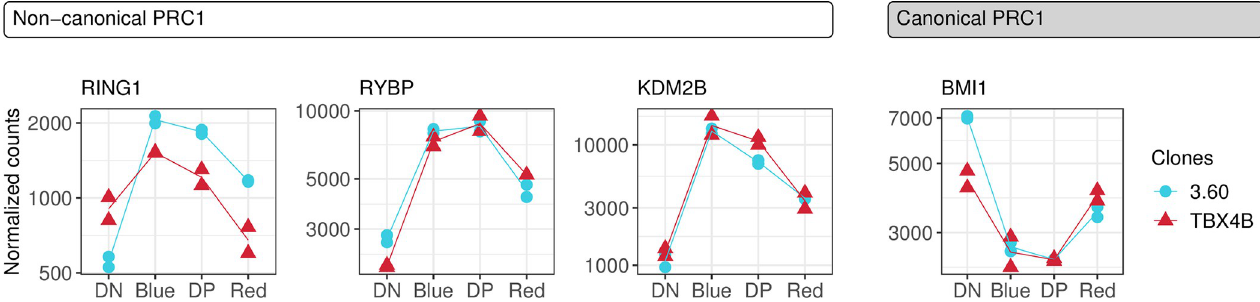
PLOS Pathogens| https://doi.org/10.1371/journal.ppat.1010387 May 16,